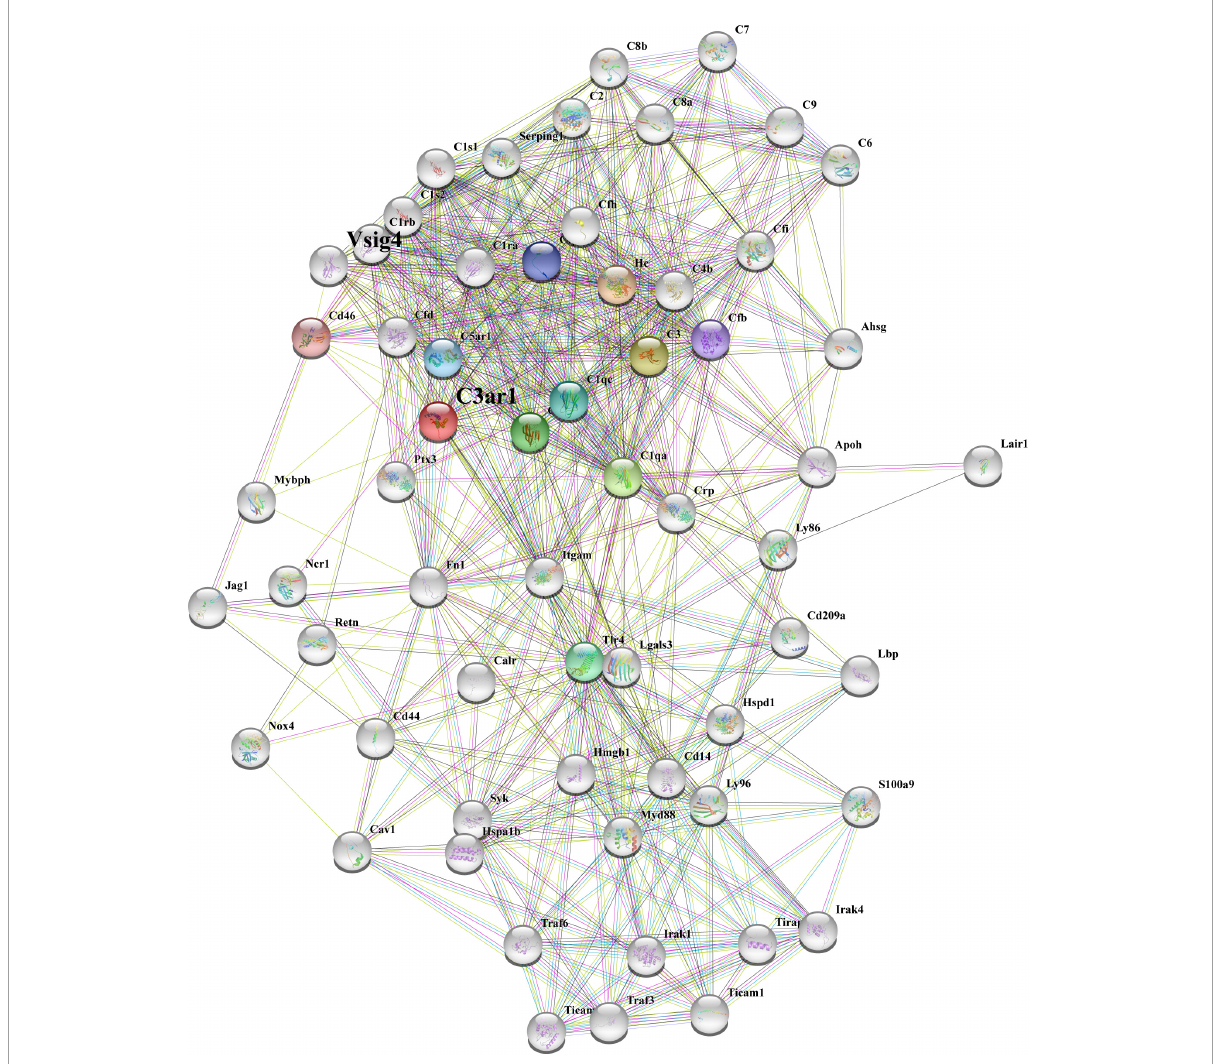
FIGURE2 STRING network analysis reveals a C3ar1-centered immune interaction network. STRING network analysis of the C3ar1-related protein interaction network. Network nodes represent proteins. Edges represent protein–protein associations. Number of nodes: 11, number of edges: 37, average node degree: 6.73, average local clustering coefficient: 0.849, expected number of edges: 11, PPI enrichment p -value: